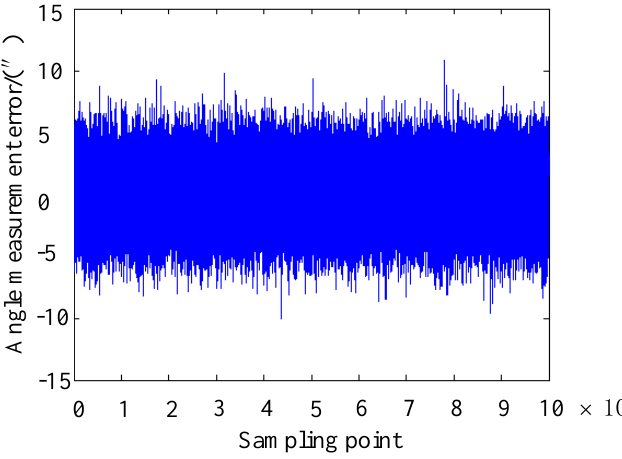
Figure 3. Synthetic analysis result using MC stochastic